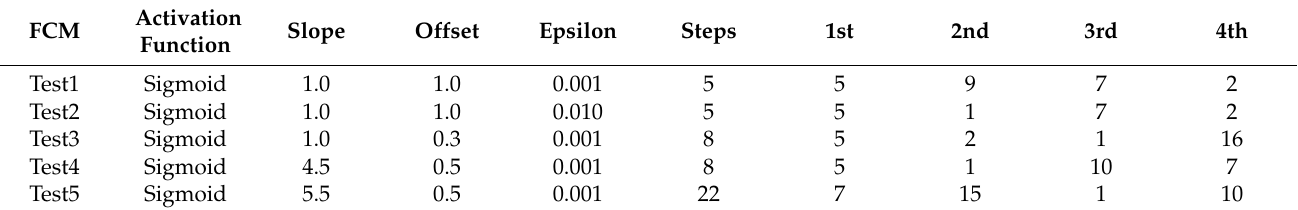
Table 7. FCM test runs—map 1.